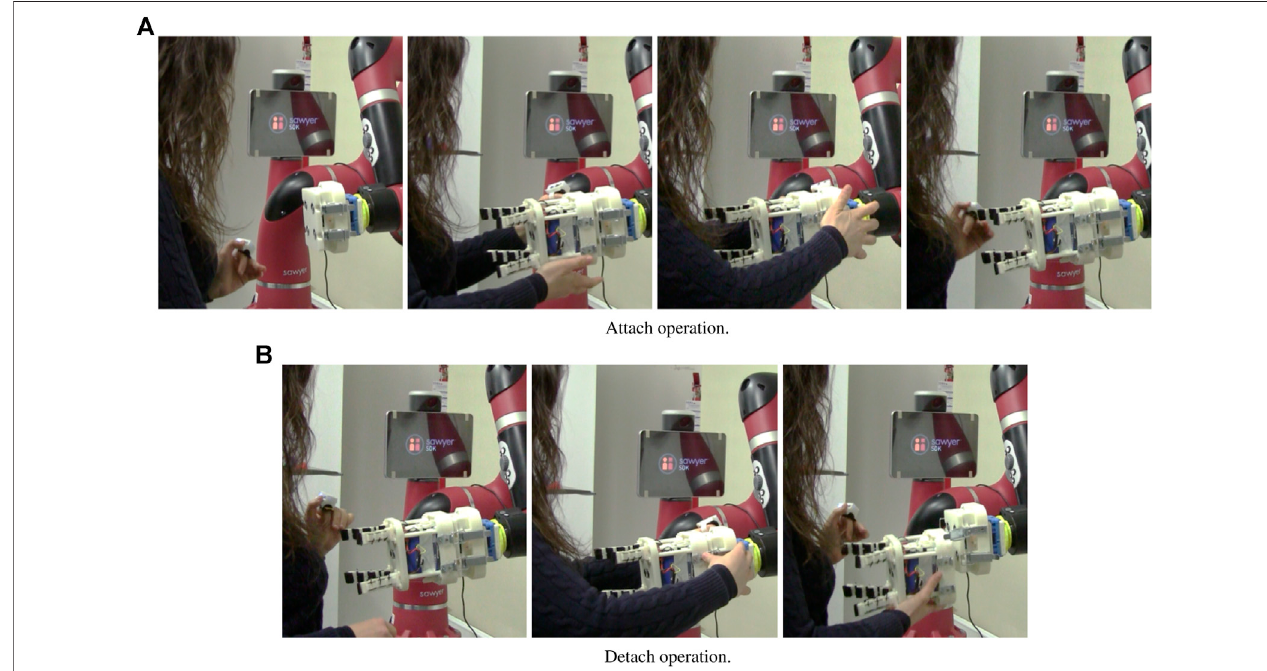
FIGURE 7 | Attach and detach sequences performed by the participants of the usability study.